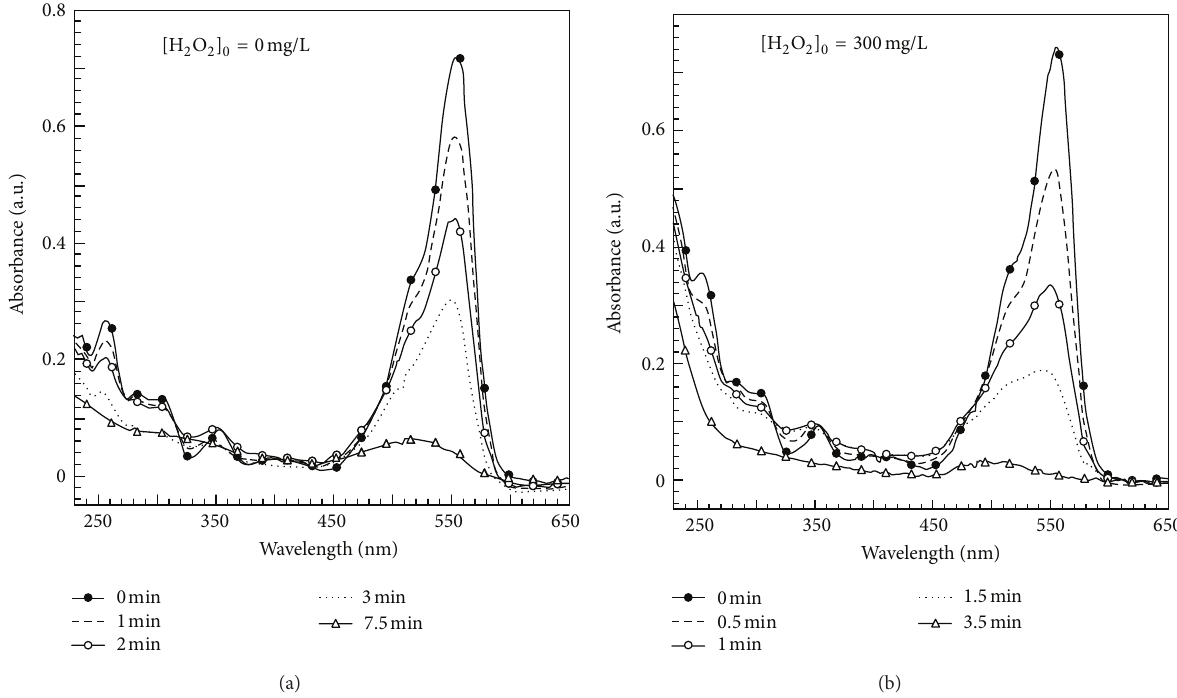
Figure 3: Absorbance spectra during the RhB (10.2 mg/L) decolorisation by MW + UV, without (a) and with (b) 300 mg/L hydrogen peroxide spiked in the solution. The power at the reactor’s input was 𝑃 = 30 ± 0.5 W and 𝑇 = 40.0 ± 1 ∘ C. Spectra were smoothed (boxcar = 10 points).